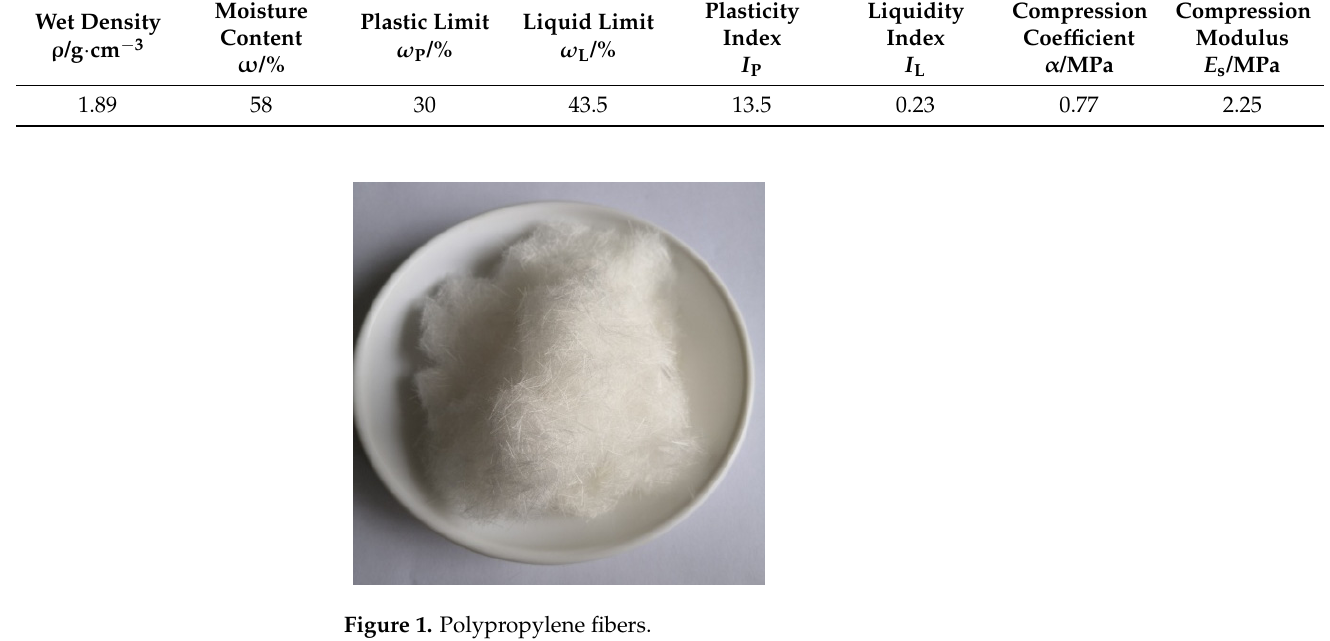
Table 3. UCS test scheme for OCC and PCC under room temperature